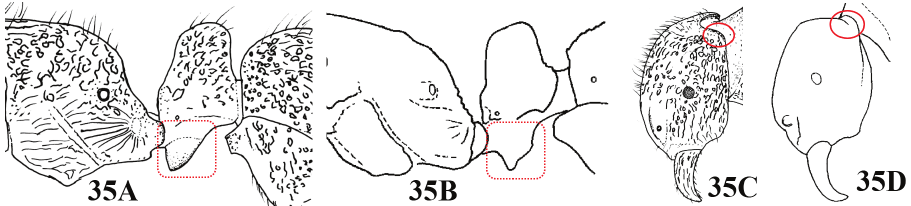
fourth abdominal sternite transversely striate ........... G. sichuanensis Lattke